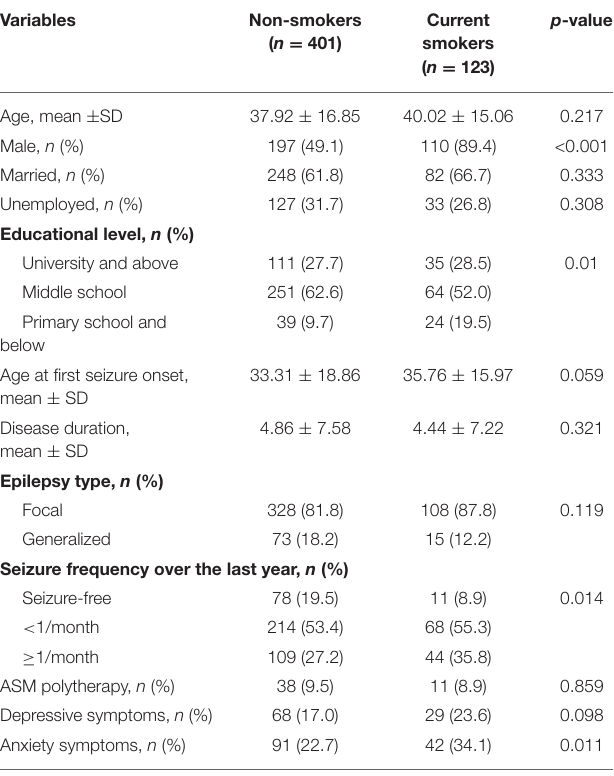
TABLE 2 | Comparison of the demographic and clinical characteristics of current smokers and nonsmokers with epilepsy. Variables